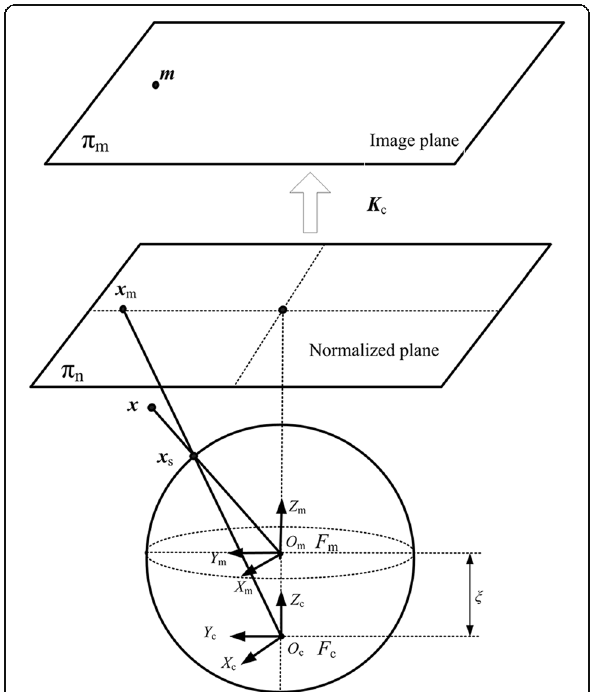
Fig. 1 Unified sphere-imaging model for a single-view-point, catadioptric, omnidirectional